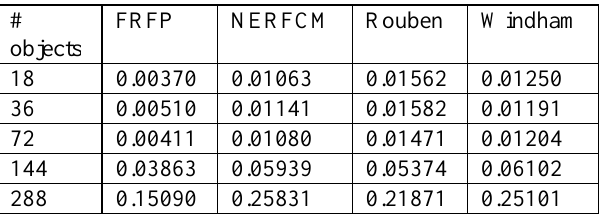
Table 13 Execution times for several trials for various sized proximity matrices of type